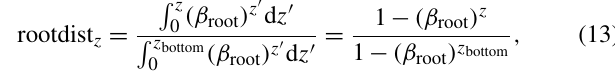
Table 1. C:N ratios relative to the leaf C:N ratio R i for the different plant compartments. Plant Root R 1 Sapwood R 2 Storage organ R 3 Pool R 4 Tree 1 . 16 6 . 9 Grass 1 . 16 Temperate cereals 1 . 16 0 . 99 3 Rice 1 . 16 1 . 30 3 Maize 1 . 16 0 . 83 3 Tropical cereals 1 . 16 0 . 79 3 Pulses 1 . 16 0 . 45 3 Potatoes 1 . 16 1 . 74 3 Sugar beet 1 . 16 4 . 46 3 Tropical roots 1 . 16 3 . 27 3 Sunflower 1 . 16 3 Soybeans 1 . 16 0 . 42 3 Groundnut 1 . 16 3 Rapeseed